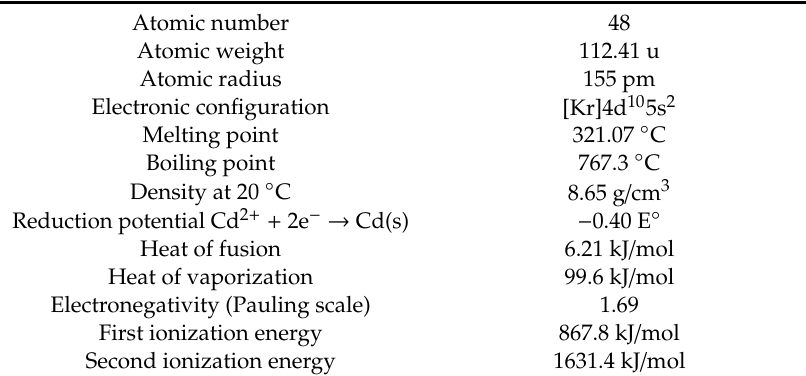
Table 1. Physical and chemical properties of